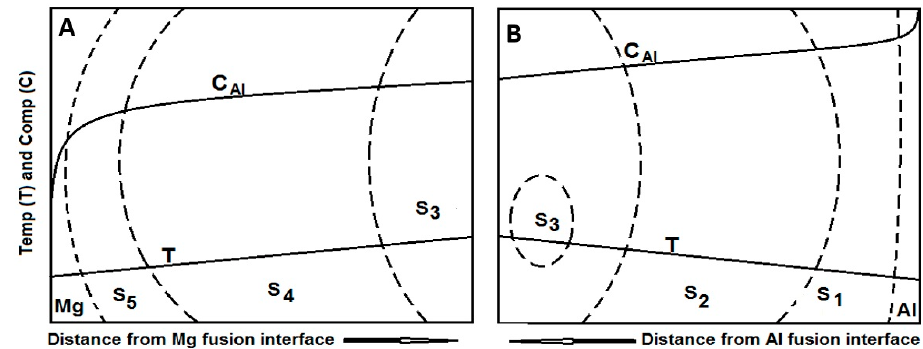
Figure 10. Schematic of the weld nugget showing the relationship between the temperature and compositional gradients and the phase formation across the weld zone ( A ) Magnesium interface to the weld center ( B ) Aluminum interface to the weld center.